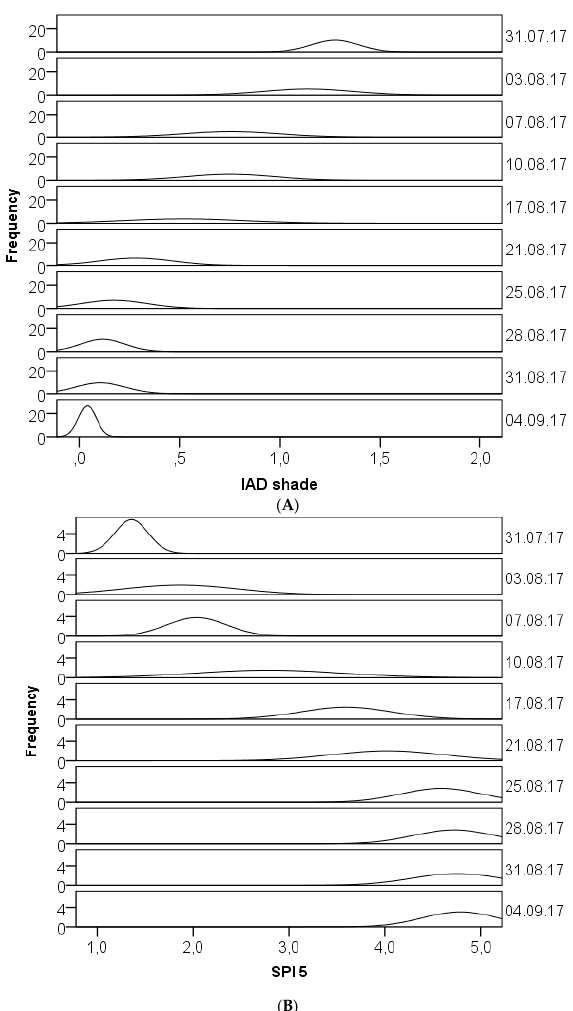
Agronomy 2019 , 9 , x FOR PEER REVIEW